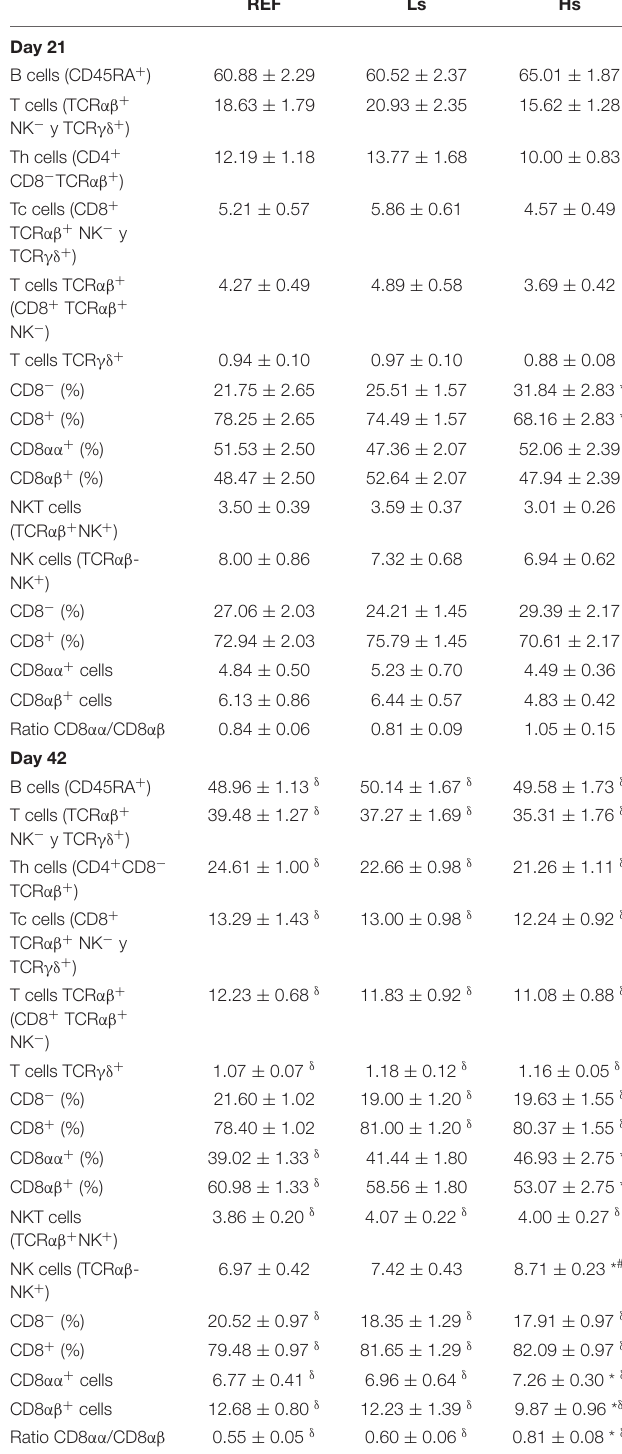
TABLE 2 | Plasma cytokines concentration at the end of the supplementation (day 21 of life) and 3 weeks after (day 42 of life). Cytokine (pg/mL)